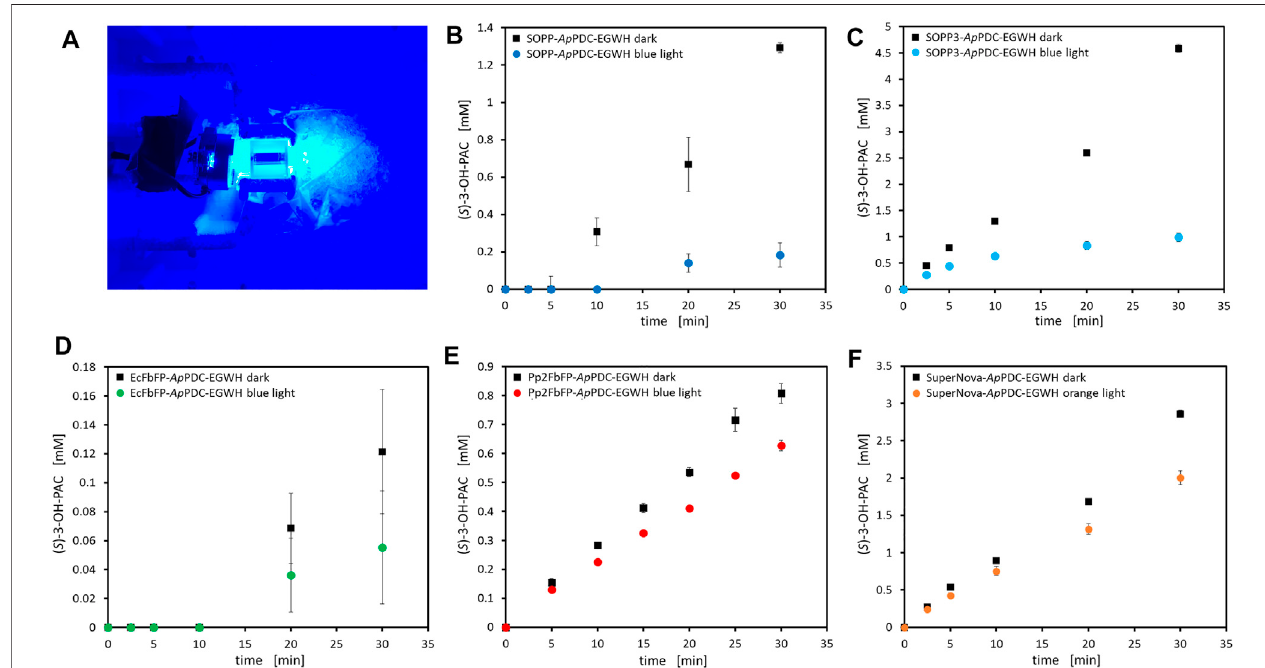
FIGURE 8 | Use of a single blue LED ( λ max = 450 nm, ~60 mW cm − 2 ; (A) ) or a single orange LED ( λ max = 610 nm, ~40 mW cm − 2 ; only for SuperNova- Ap PDC- EGWH) for the 30 min lasting light inactivation of the puri fi ed and lyophilized fusion enzymes SOPP- Ap PDC-EGWH (3.0 mg ml − 1 ; (B) ), SOPP3- Ap PDC-EGWH (1.0 mg ml − 1 ; (C) ), EcFbFP- Ap PDC-EGWH (3.6 mg ml − 1 ; (D) ), Pp2FbFP- Ap PDC-EGWH (4.0 mg ml − 1 ; (E) ) and SuperNova- Ap PDC-EGWH (1.0 mg ml − 1 ; (F) ) and the corresponding reactions in the dark. General reaction conditions: 40 mM 3-hydroxybenzaldehyde, 200 mM pyruvate (sodium salt) and 50 mM HEPES buffer (pH 6.5)with2.5 mMMgSO 4 ,0.1 mMThDP.Incubationon1 mlscaleat22 ° Cand850 rpminathermomixer(darkconditions)orinastirredquartz-glasscuvette(illuminated setups). The error bars describe standard deviation of technical